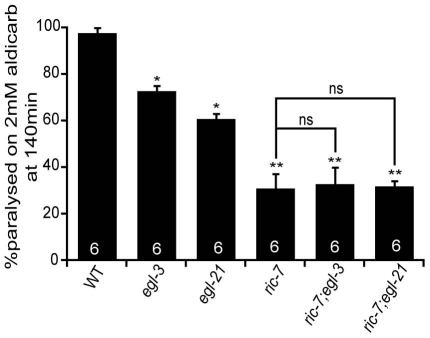
Neuropeptide processing mutations and  The paralytic response to aldicarb treatment was analyzed in strains containing mutations that inactivate pro-neuropeptide processing enzymes (egl-3 PC2 and egl-21 CPE), or those inactivating RIC-7. The number of trials (∼20 animals/trial) is shown for each genotype. Values that differ significantly from wild type (*, p<0.01; **, p<0.001, Students t-test) are indicated. Error bars indicate SEM. Values that are not significantly different are indicated (ns).